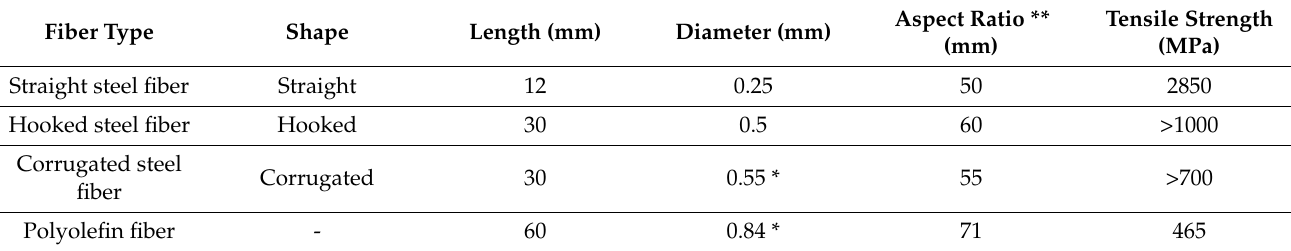
Table 4. Properties of fibers used.